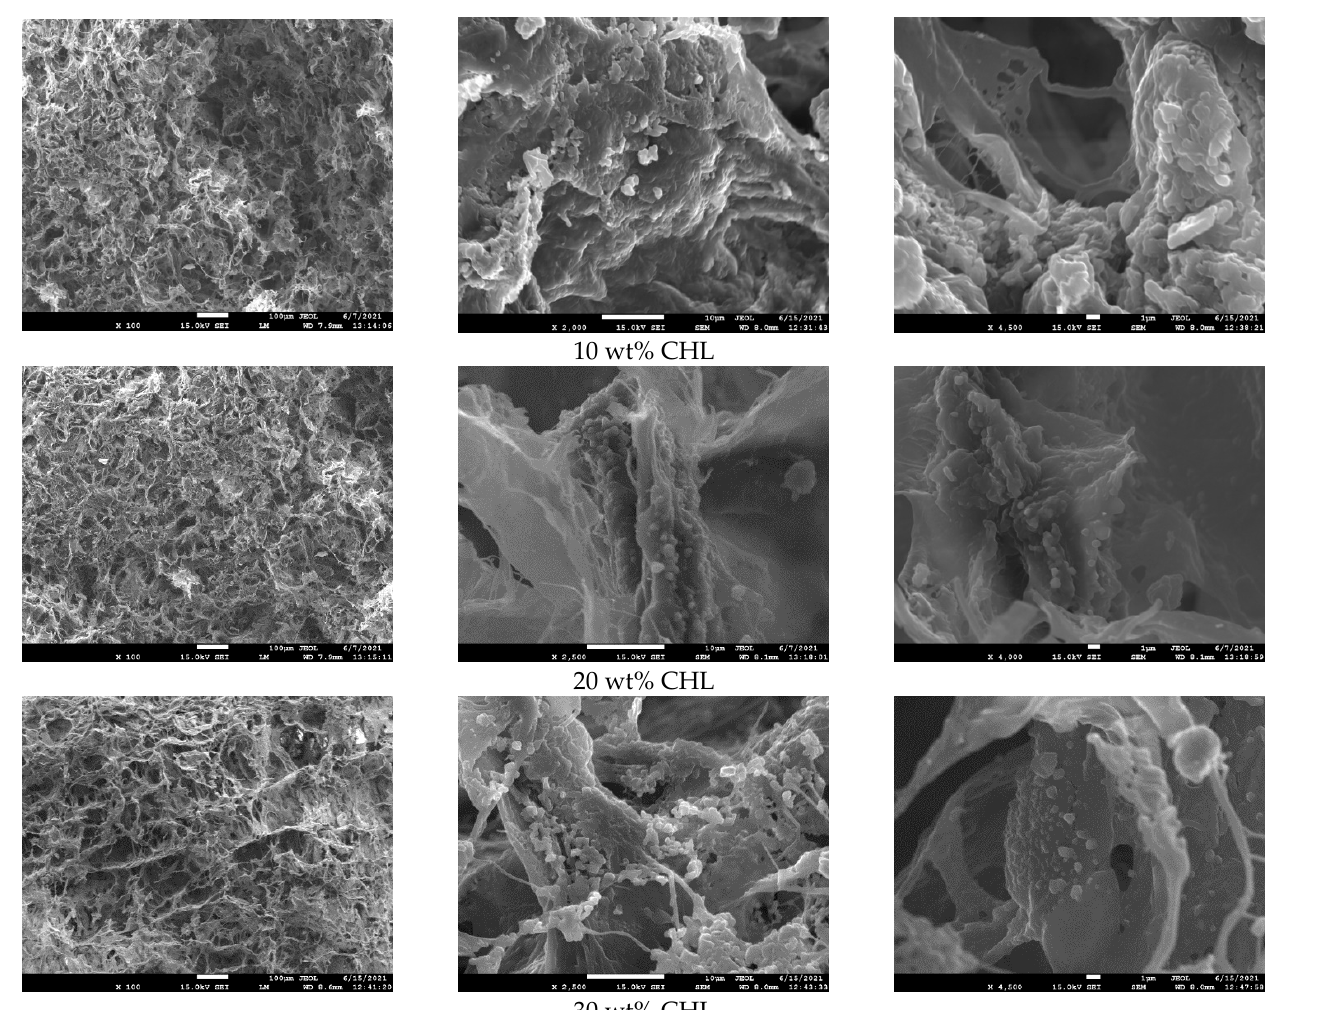
Figure 11. SEM micrographs of prepared poly(vinyl alcohol) (PVA)/cellulose nanofibril (CNF)/chloramphenicol (CHL) sponges after CHL release.